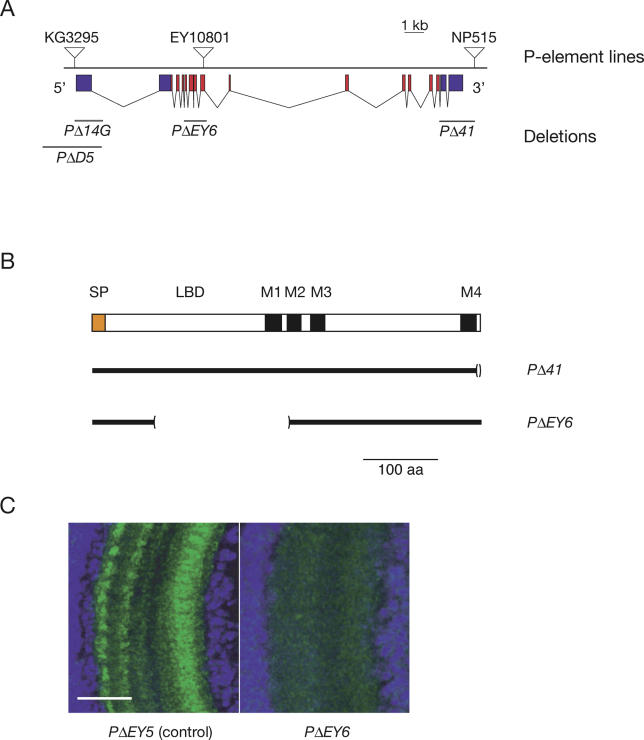
Genomic Structure and Mutational Analysis of theDα7 Gene(A) TheDα7 gene consists of 16 exons. The 5′ and 3′UTRs are drawn in blue, and the ORF is colored red. The insertion sites of the three P-elements are shown above the gene, while the extent of each deletion generated by imprecise excision of the P-elements is depicted below.(B) The structural domains of the Dα7 protein are shown in a schematic representation, and the minimum extent of the lesion associated with the two deletions that remove part of the ORF are indicated by brackets, (), below. Abbreviations: LBD, ligand-binding domain; M1–M4, transmembrane domains 1–4; SP, signal peptide.(C) Immunostaining using an anti-Dα7 antibody is absent inPΔEY6. Here representative staining in the medulla is shown. The precise excisionPΔEY5 (left image) was used as a control, and whole-mount of the mutant and control brains were processed together. Scale bar, 20 μm.